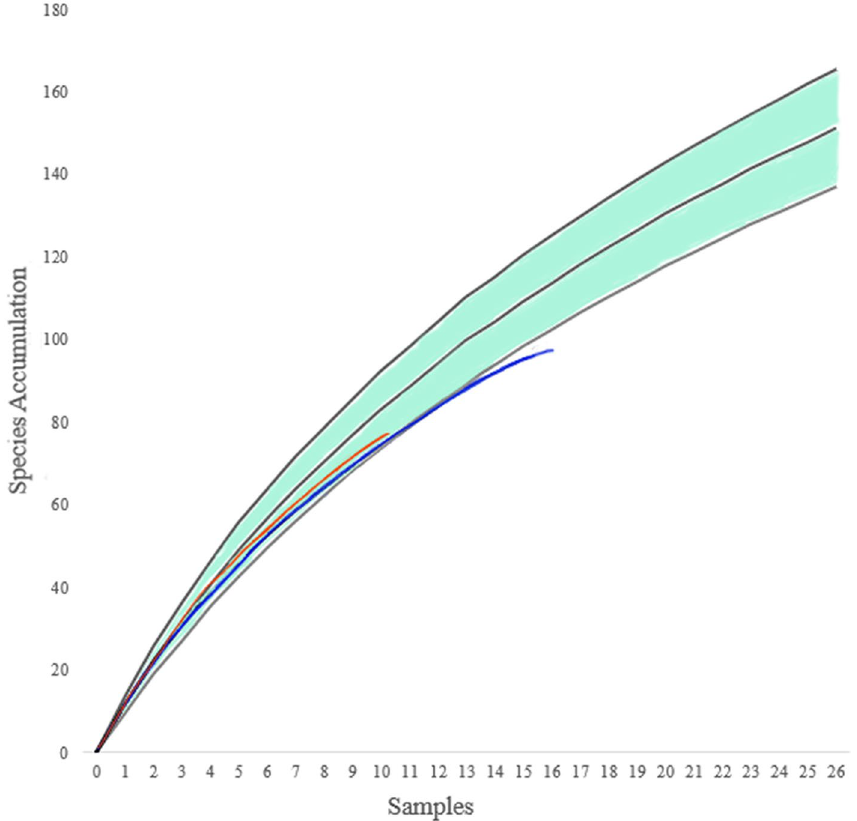
Figure 4. Accumulation curves of tachinid species against the number of samples. The green highlight is the species richness for 2017–2019 with the species richness accumulation in the center ± 95% CI. The red curve and the blue curve are the species richness accumulation curves for 2017 and 2018–2019, respectively. Curves are based on 1,000 randomizations.